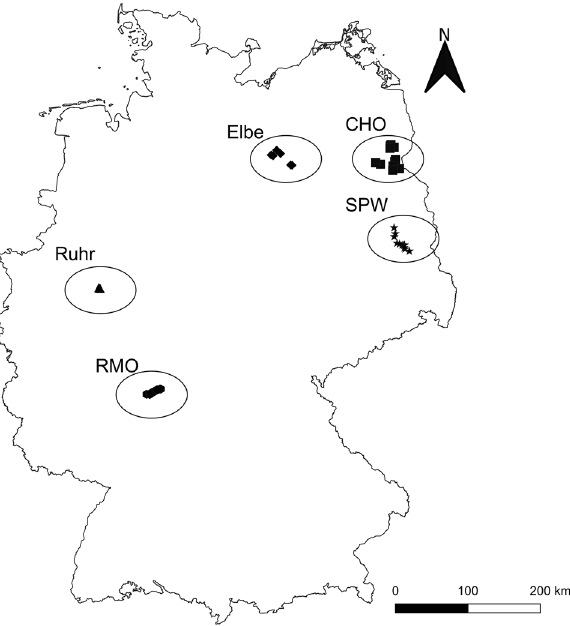
Figure 1. Location of the 40 sampling sites within five regions in Germany. Within regions, sites have identical symbols; ovals around the sites represent regions. Region labels are described in Table